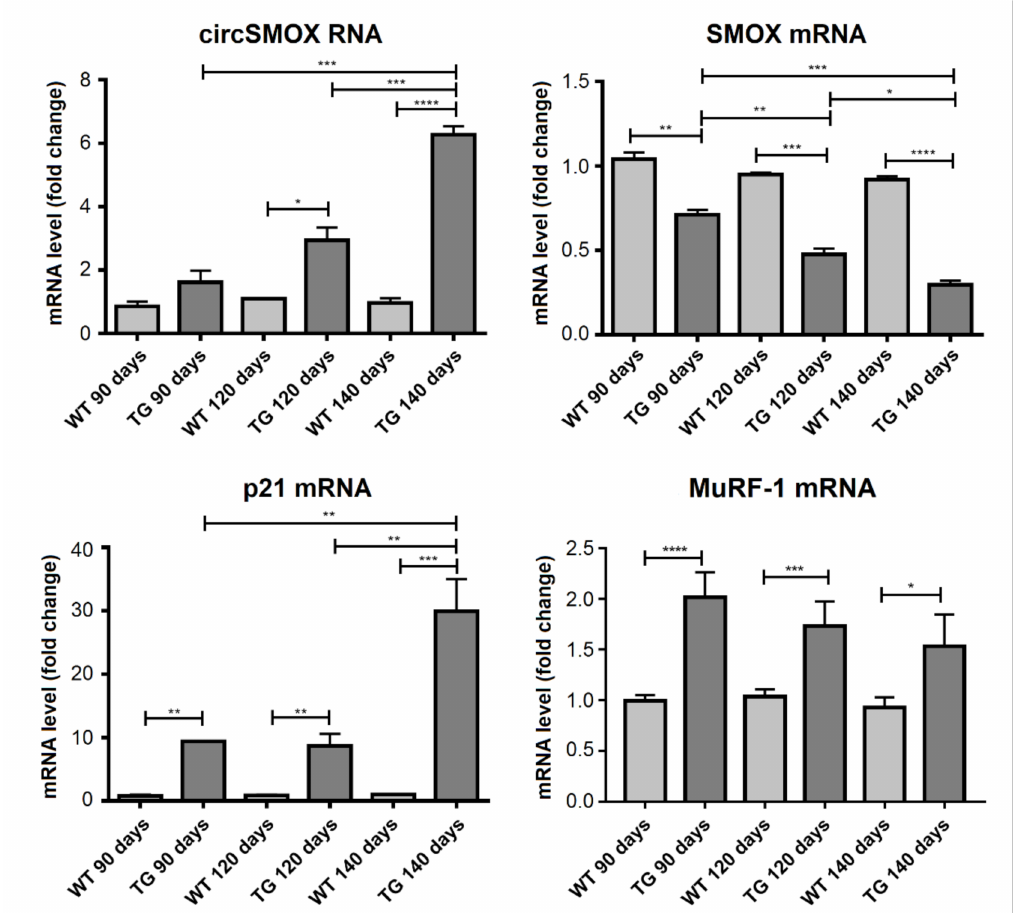
Figure 8. Linear and circular SMOX RNA expression in SOD1 G93A mice. qRT-PCR of linear